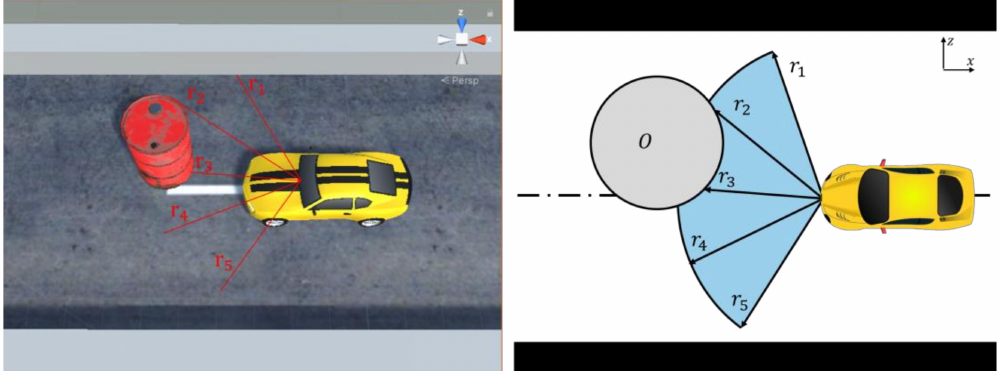
Figure 7. Using ray sensors to perceive learning environment information. The left is the actual vehicle encountering obstacles during driving in the virtual environment, and the right is the geometric schematic diagram of the left picture. The blue fan-shaped area is the sensing area of the sensor, and ( r 1 , r 2 , r 3 , r 4 , r 5 ) is the ray emitted by the